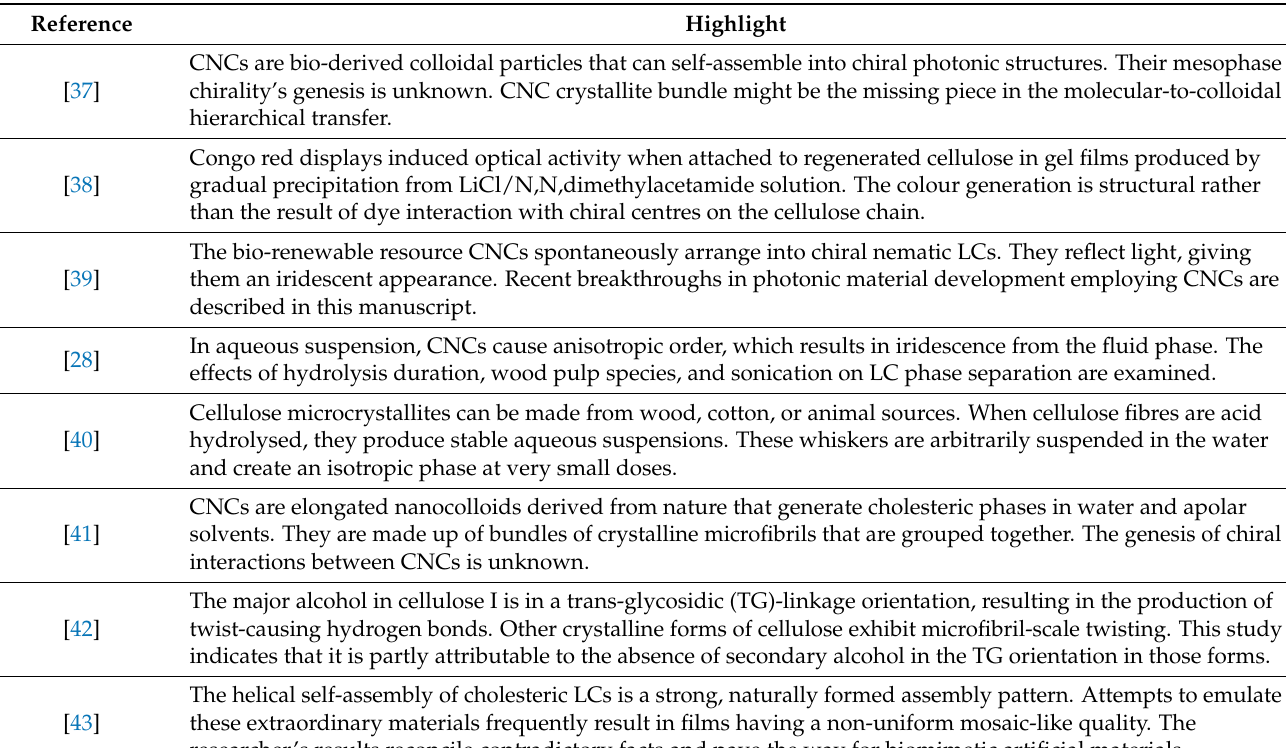
Table 1. The table provides highlights on studies containing discussion and research on chiral LCs out of